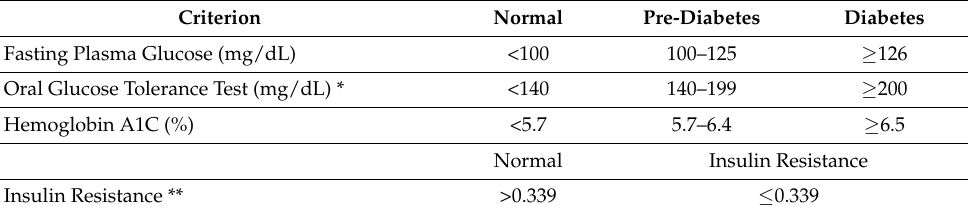
Table 6. Criteria for the diagnosing of Dysglycemia and Insulin Resistance. Criterion Normal